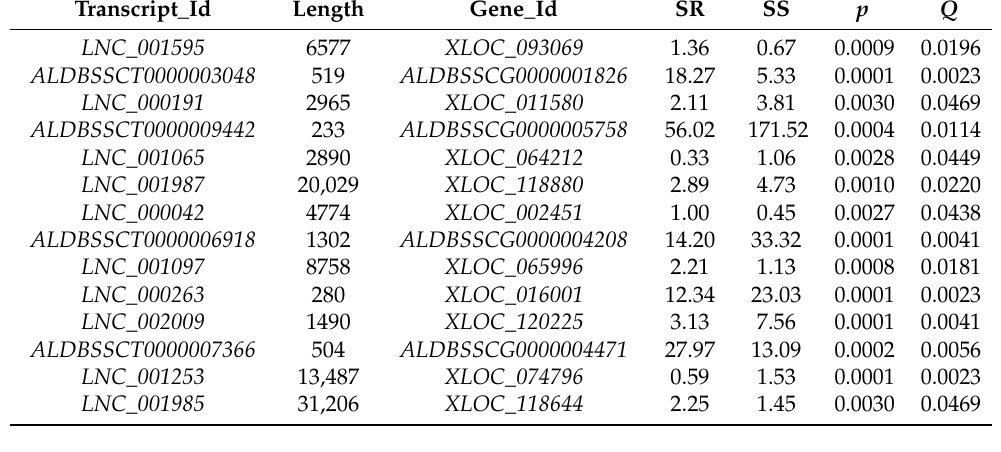
Figure 2. Distributions of DE lncRNAs and mRNAs in pig chromosome. The x -axis indicates differ- ent chromosomes, and the y -axis indicates the number of lncRNAs or mRNAs.